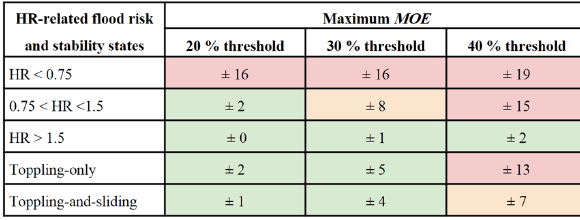
Figure 11. Thresholds of floodwater depth to body height that are specified for pedestrian agents to accommodate uncertainty associ- ated with different risk perception of people in the real-world case study.